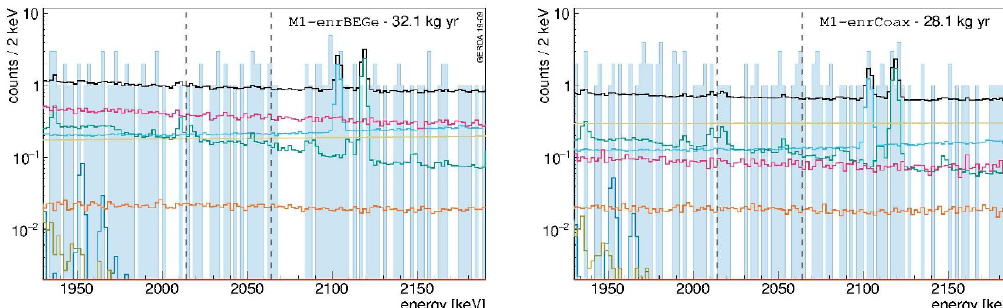
Figure 5. Background decomposition for the M1-enrBEGe (left) and the M1-enrCoax (right) data sets in the background window between 1930 keV and 2190 keV after data unblinding. The previ- ously blinded window ( Q (cid:12)(cid:12) (cid:6) 25 keV) is indicated by two dashed lines. The background distribution before active background suppression in the 0 (cid:23)(cid:12)(cid:12) analysis window can be well approximated with a constant function. For color code see (cid:12)gure 4.